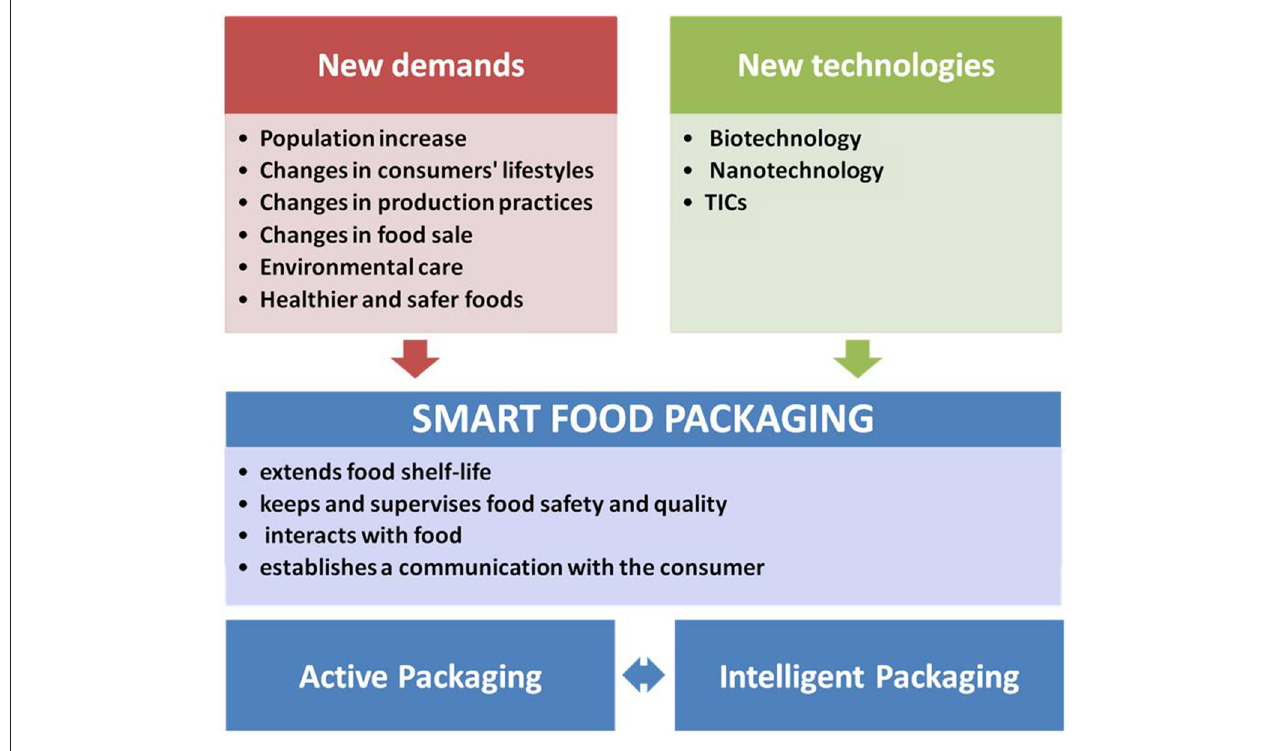
FIGURE 5 | Outline of the driving forces that lead to the development of smart food packaging.